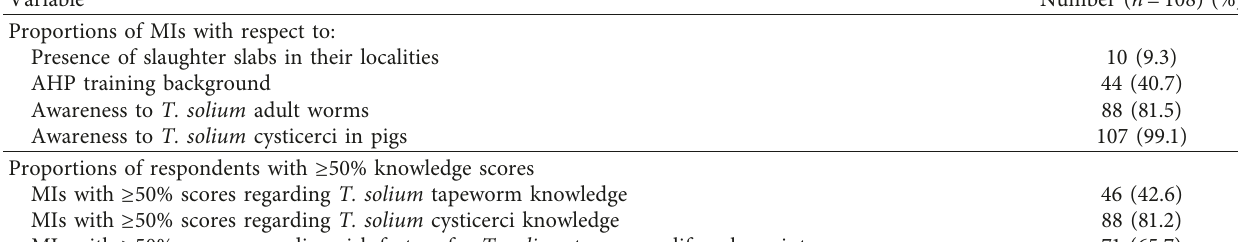
Table 4: Knowledge of meat inspectors regarding T. solium adult tapeworm and T. solium cysticercosis diagnosis. Variable